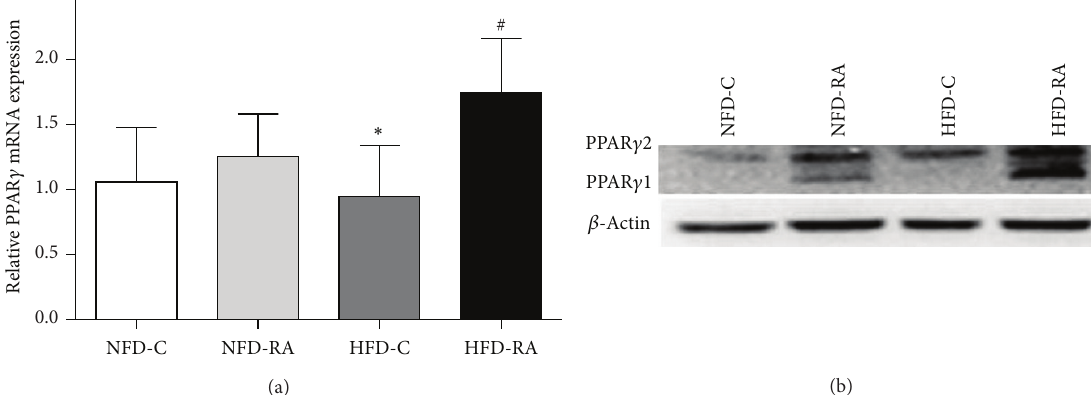
Figure 4: RA upregulates the expression of PPAR 𝛾 in the intra-abdominal white adipose tissue. (a) mRNA levels of PPAR 𝛾 from epididymal fat pad were measured by qRT-PCR. ∗ 𝑃 < 0.05 (HFD-C group versus NFD-C group) and # 𝑃 < 0.05 (HFD-RA group versus HFD-C group). (b) Protein levels of PPAR 𝛾 in epididymal fat